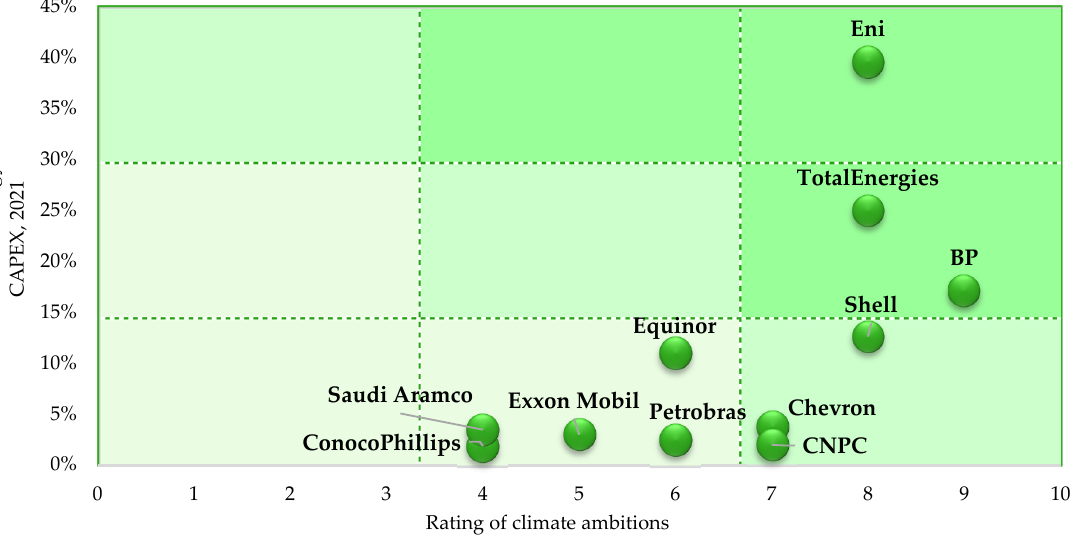
Figure 3. Climate ambitions of global oil and gas companies. Source: Created by the authors using data from [65–69,71–80].